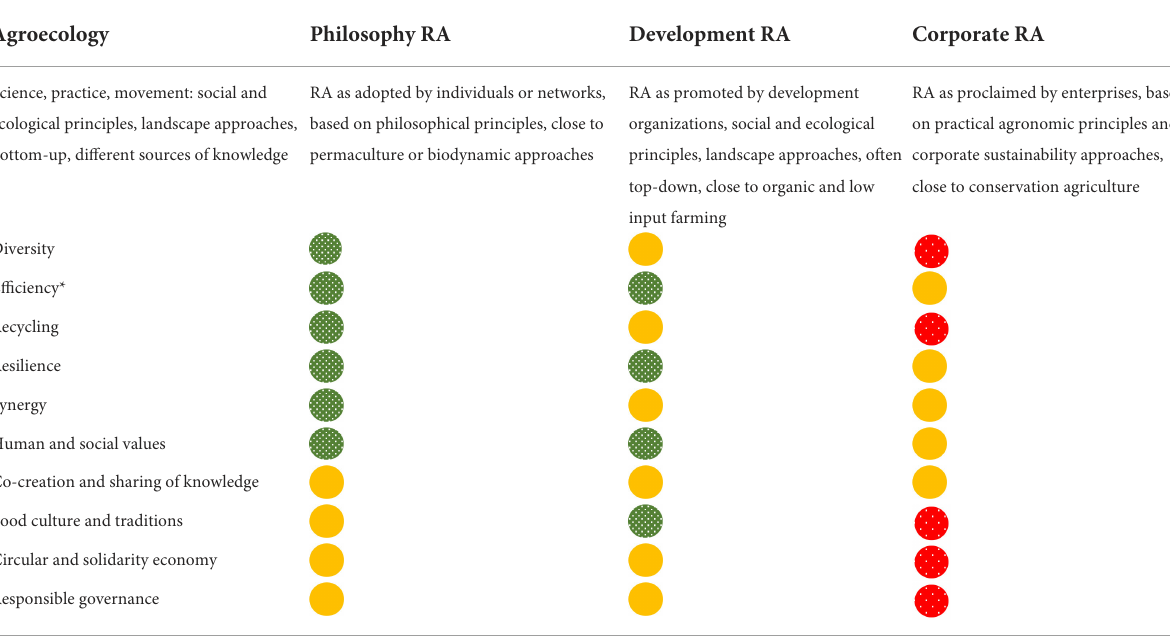
TABLE 1 A comparison between agroecology and three different types of regenerative agriculture (RA), using the 10 elements that define agroecology (FAO, 2019).